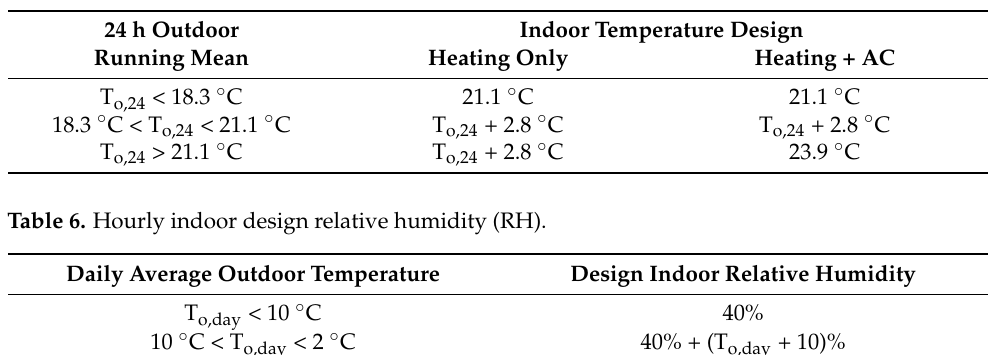
Table 5. Hourly indoor design temperature (T).